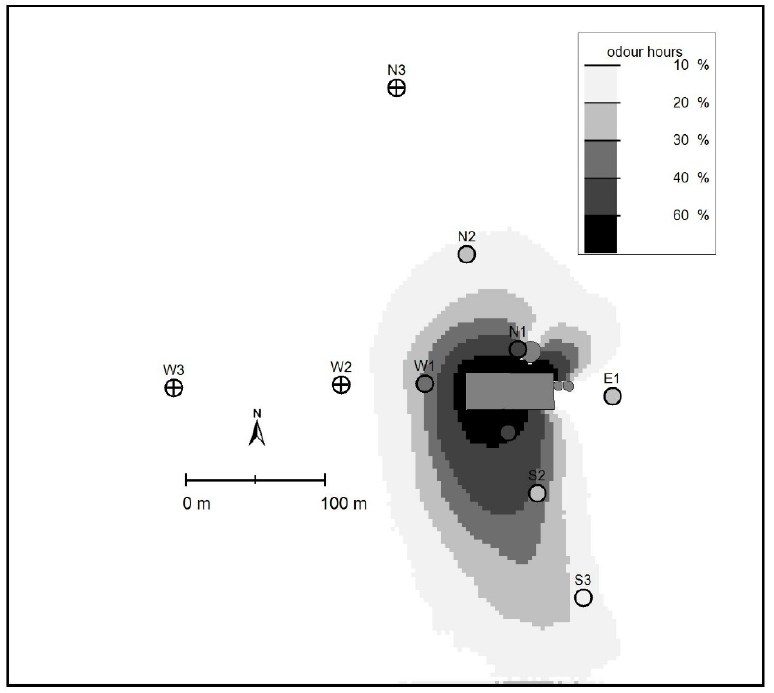
Figure 6. Simulated odour–hour frequencies with the Lagrangian particle model GRAL using an emission rate of 3.5 MOU E h − 1 . Observed odour-hour frequencies are depicted by the circles. Sites N3, W2, and W3 were not included in the field campaign.